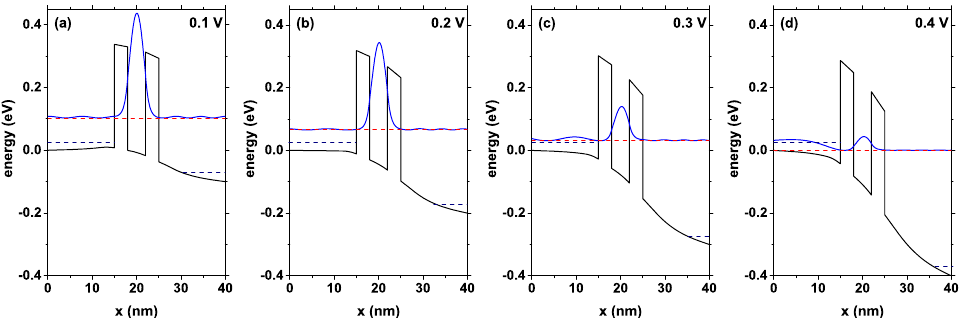
Figure 4. Potential energy change with bias voltage from 0.0 V to 0.4 V, the blue curve corresponds to the resonant state probability density and the red curve is the energy for this state E 0 . The quasi-Fermi level is also presented by the dark blue dashed line for emitter and collector. The calculations are for L w = 4nm, L b = 3nm, L s = 3nm, L d = 12nm, and n d = 1.2 × 10 18 cm − 3